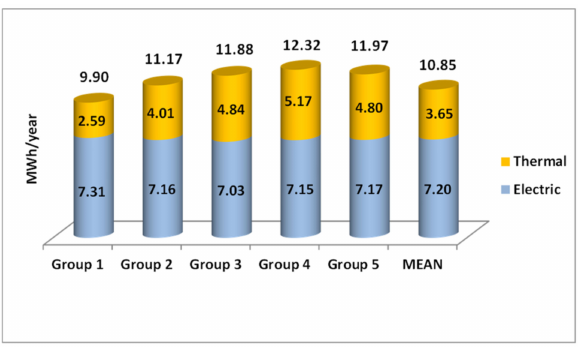
Figure 5. Thermal, electric, and total mean energy consumption per household of each group of cities.